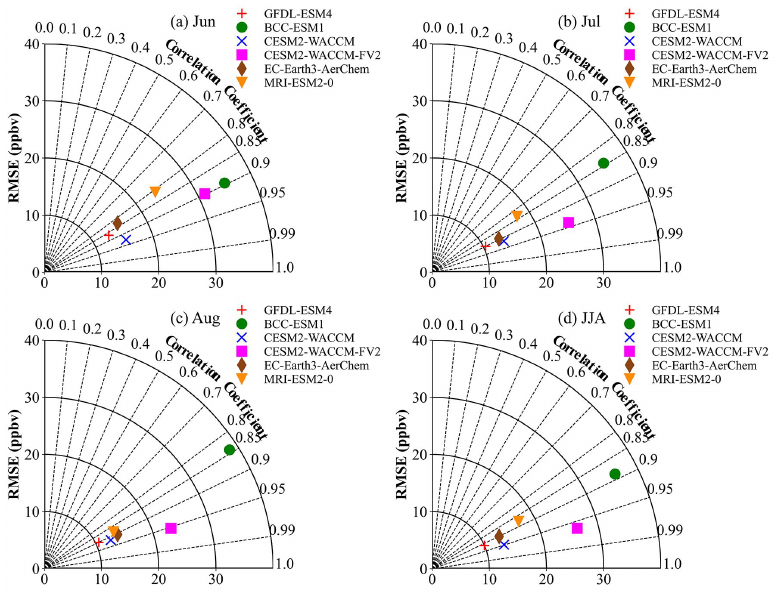
Figure 7. Spatial correlation coefficients and root mean square errors of the 100 hPa CO mixing ratio from CMPI6 model simulations with MLS observations for June ( a ), July ( b ), August ( c ), and JJA mean ( d ) during 2005–2014. Angular axes show correlations between 100 hPa CO mixing ratio from MLS and individual model simulation; radial axes show standard deviation (root-mean-square deviation, unit: ppbv). Each symbol represents a